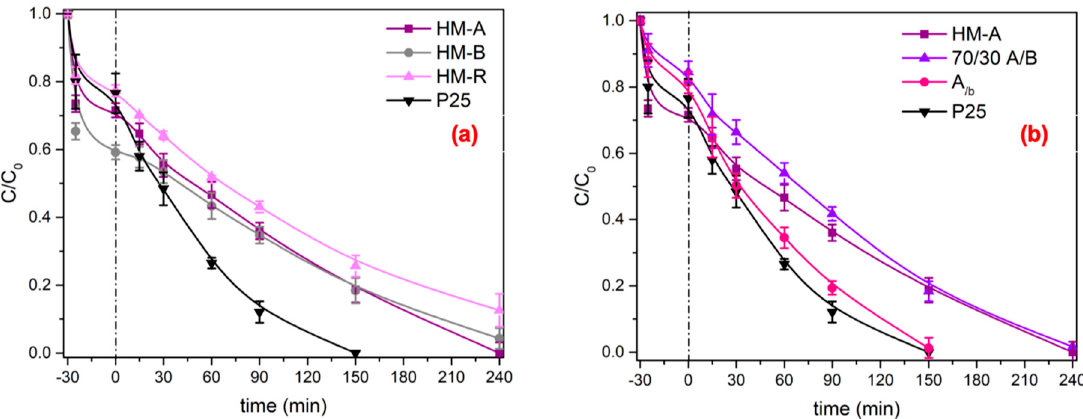
Figure 7. Photo-assisted elimination of methyl orange with di ff erent TiO 2 nanophase particles under dark ( − 30 to 0 min) and UV illumination (0 to 240 min) conditions: ( a ) comparison of aqueous-synthesized pure phase anatase (HM-A), brookite (HM-B), and rutile (HM-R) with commercial P25; and ( b ) comparison of aqueous-synthesized pure phase anatase (HM-A), physical mixture of aqueous-synthesized pure anatase and brookite (70% A / 30% B), and aqueous-synthesized mixed-phase ( A / b , 70% A / 30% B) nanoTiO 2 . Conditions; catalyst loading 1 g TiO 2 / L, C MO : 25 mg / L. UV lamp characteristics: 10 W output, wavelength range of 200–280 nm, peak at 254 nm, power density of 30 mW / cm 2 , by Atlantic Ultraviolet Corporation.